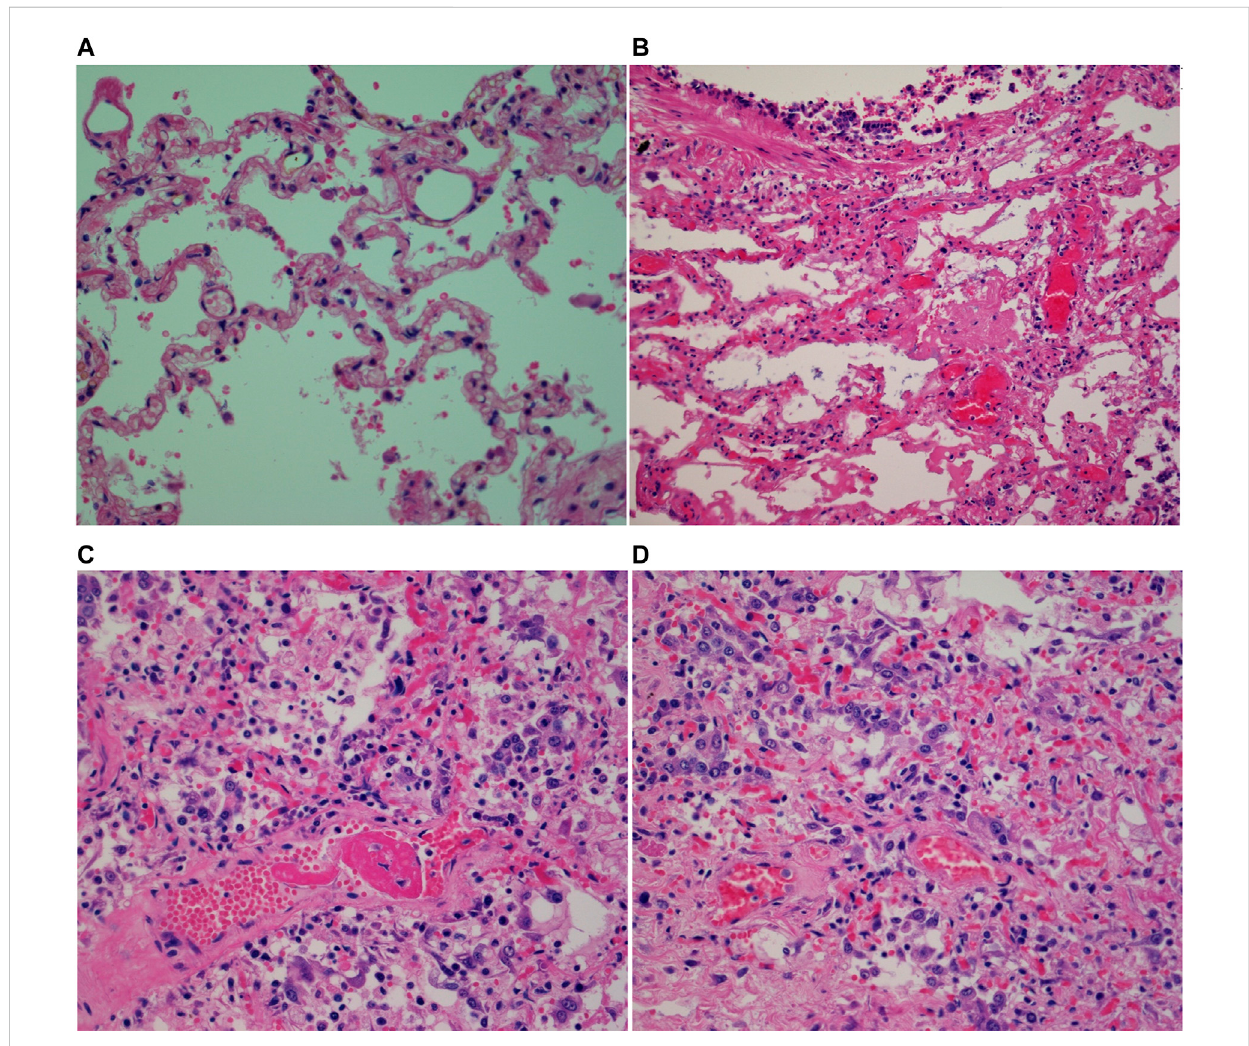
FIGURE 3 Micrographs of H&E stained postmortem human lung tissues (×40 magni fi cation with an Olympus B×43 microscope) showing (A) normal human lung; (B) hyaline membrane formation; (C) perivascular lymphocytes; (D) COVID-19 organizing